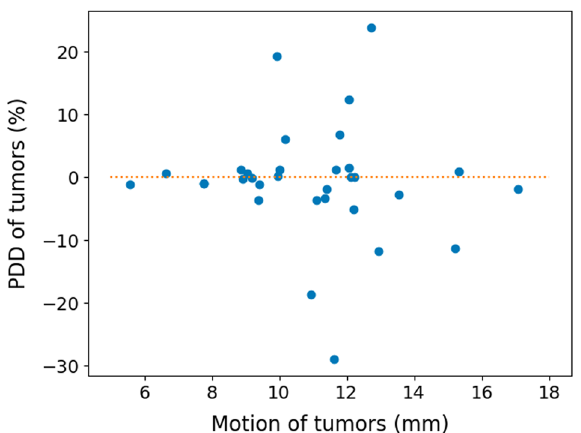
Fig. 7 Percentages of tumor dose difference between 3D and 3Dcomp reconstructions with respect to the amplitude of the